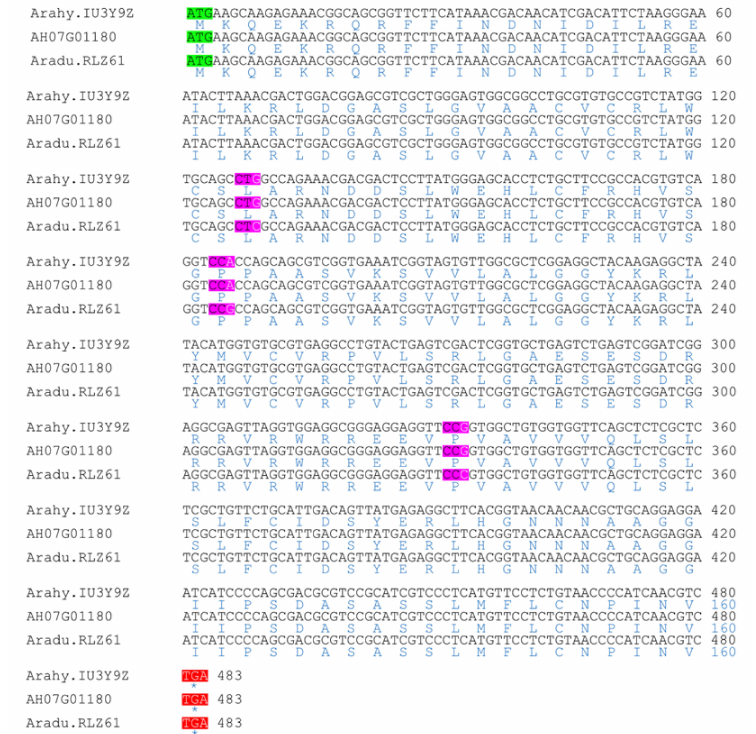
Figure 4. Sequence alignment of A. duranensis SNE ( Aradu.RLZ61 ), A. hypogaea subs. hypogaea var. Tifrunner SNE ( Arahy.IU3Y9Z ) and A. hypogaea subs. fastigiata var shitouqi SNE ( AH07G01180 ). The CDS sequences are figured in black and the corresponding protein sequences in blue. Three codons with SNP variation are highlighted in pink. The start codon is figured in